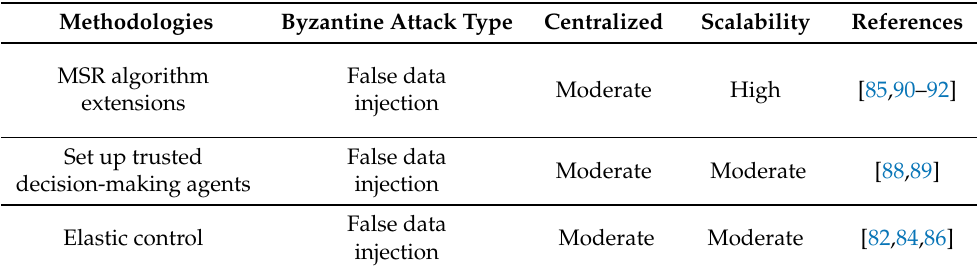
Table 4. Recent Work on Byzantine